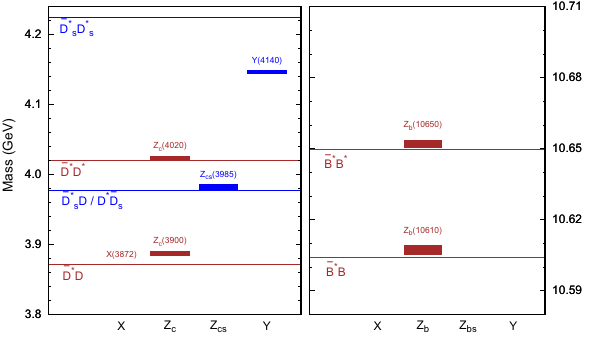
Fig. 1 The experimental masses of X ( 3872 ) , Z c ( 3900 ) , Z c ( 4020 ) , Z b ( 10610 ) , Z c ( 10650 ) , Z cs ( 3985 ) , and Y ( 4140 ) with relevant thresh- olds. The values are from the Review of Particle Physics